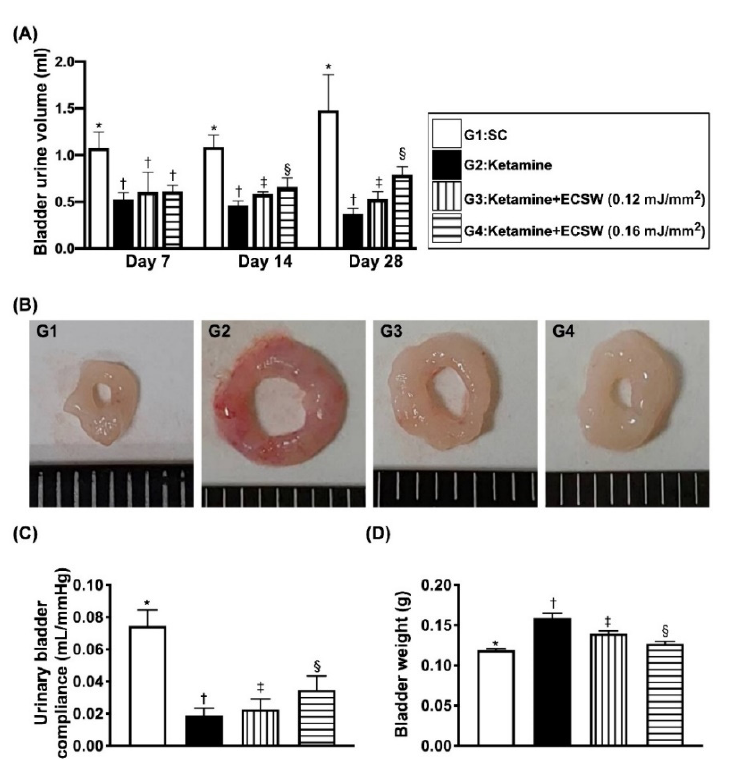
Figure 6. Time courses of mean maximal bladder urine volume per time interval prior to micturition (i.e., within 18 h collection of urine divided by total number of urination) and urinary bladder compliance, and the urinary bladder weight by day 42 after ketamine administration. ( A ) By day 7, the mean of urine volume prior to micturition, * vs. †, p < 0.001; by day 14, the mean of urine volume prior to micturition, * vs. other groups with different symbols (†, ‡, §), p < 0.0001; by day 28, the mean of urine volume prior to micturition, * vs. other groups with different symbols (†, ‡, §), p < 0.0001. ( B ) Illustrating the anatomical features of urinary bladder by day 42 after ketamine treatment. The appearance of urinary bladder was remarkably enlarged and swelling in G2 moreso than in G3 and G4 and more remarkably enlarged and swelling than in G1. ( C ) By day 28, the urinary bladder compliance, * vs. other groups with different symbols (†, ‡, §), p < 0.0001. ( D ) Analytical result of bladder weight, * vs. other groups with different symbols (†, ‡, §), p < 0.001. All statistical analyses were performed by one-way ANOVA, followed by Bonferroni multiple comparison post hoc test ( n = 6 for each group). Symbols (*, †, ‡, §) indicate signi fi cance (at 0.05 level). ECSW = extra- corporeal shock wave.